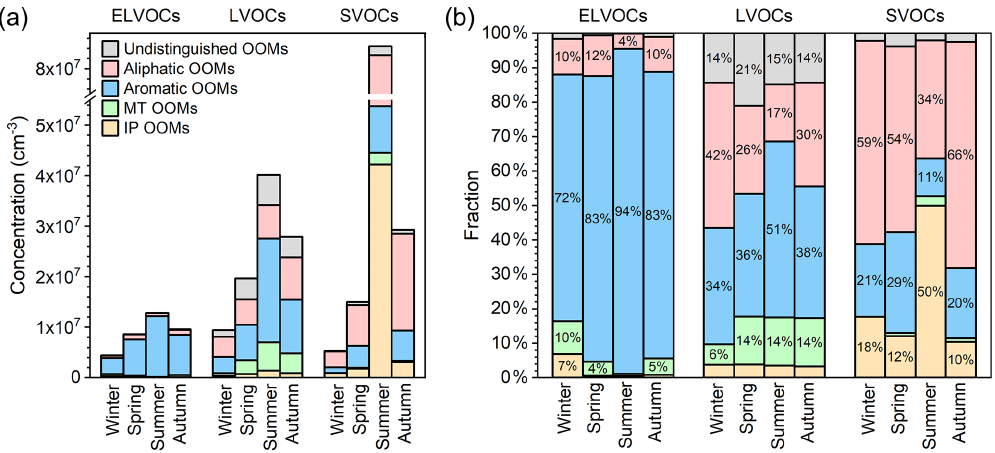
Figure 10. (a) Concentration and (b) fraction of source-classified OOMs in ELVOCs (extremely low volatile organic compounds), LVOCs (low volatile organic compounds), and SVOCs (semi-volatile organic compounds) in four seasons. Please also note that the fractions smaller than 4% are not marked.